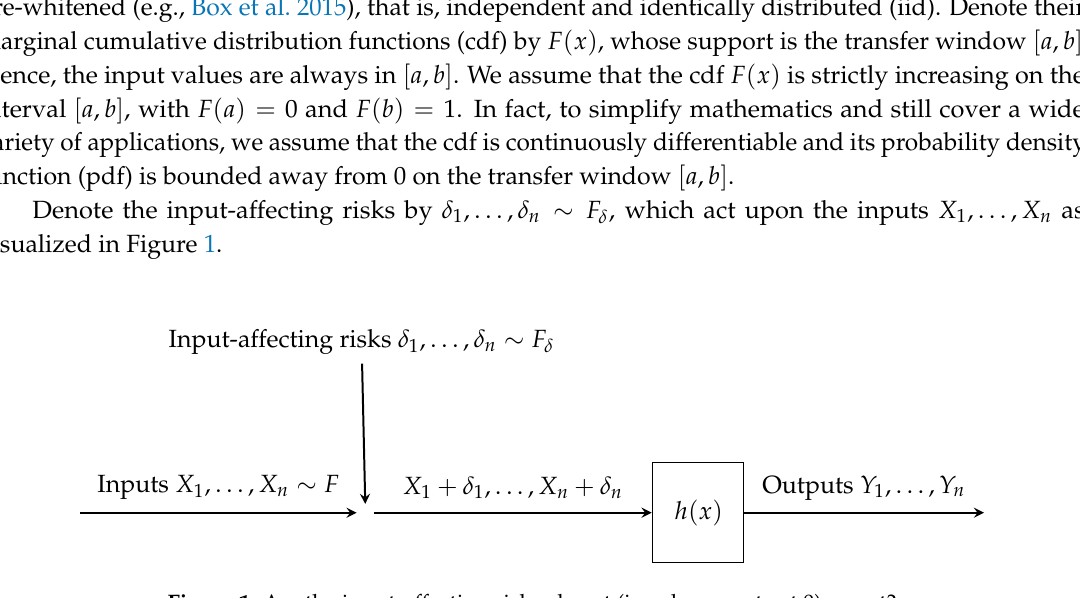
Figure 1. Are the input-affecting risks absent (i.e., degenerate at 0) or